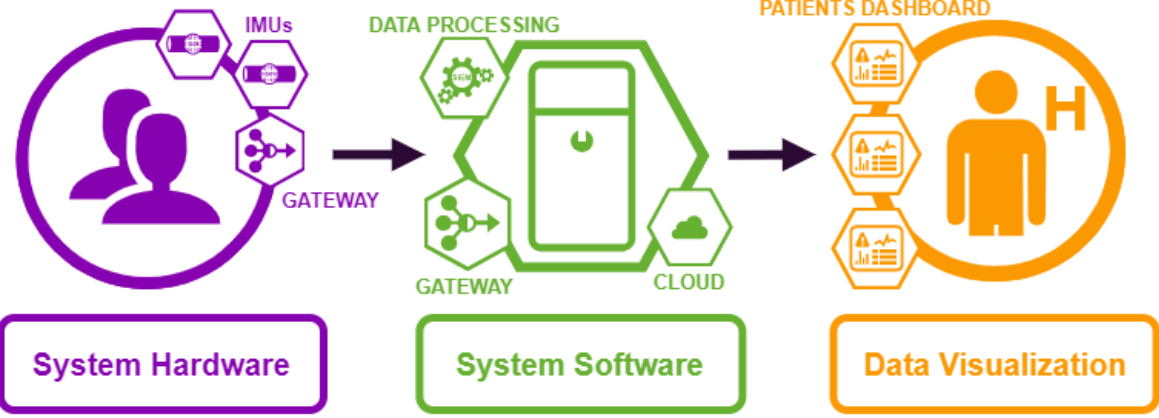
Figure 2. General scheme of the system consisting of 3 main modules (represented with different colors). The round element corresponds to an end user (human), while hexagonal elements (both hardware and software) corresponds to the system. In purple, the components of system hardware module; in green, the components of system software module and in orange, the components of data aggregation/visualization